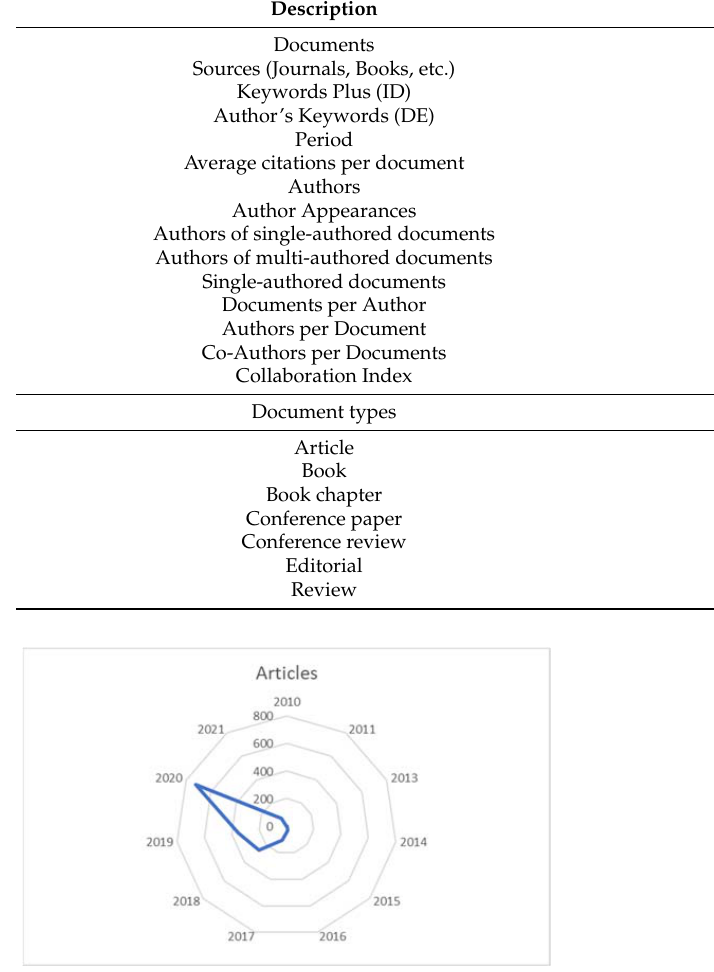
Figure 2. Annual publications production